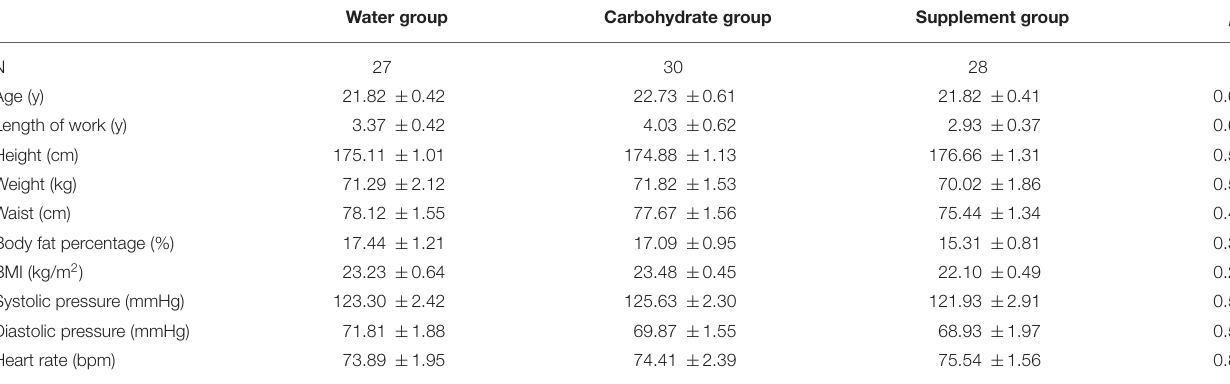
TABLE 2 | Anthropometric characteristics of participants in short-term supplement trial at